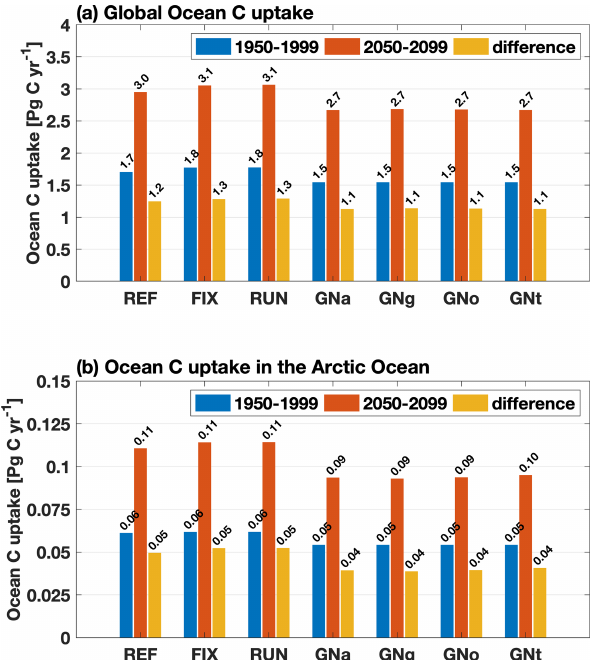
Figure 7. (a) Globally integrated annual mean ocean carbon uptake over 1950–1999 (blue) and over 2050–2099 (red) and the differ- ences between these two time periods (yellow) for all experiments; (b) same as (a) but for the Arctic Ocean (ocean area north of the Bering Strait on the Pacific side and north of 70 ◦ N on the Atlantic side) for the same time periods as in (a)